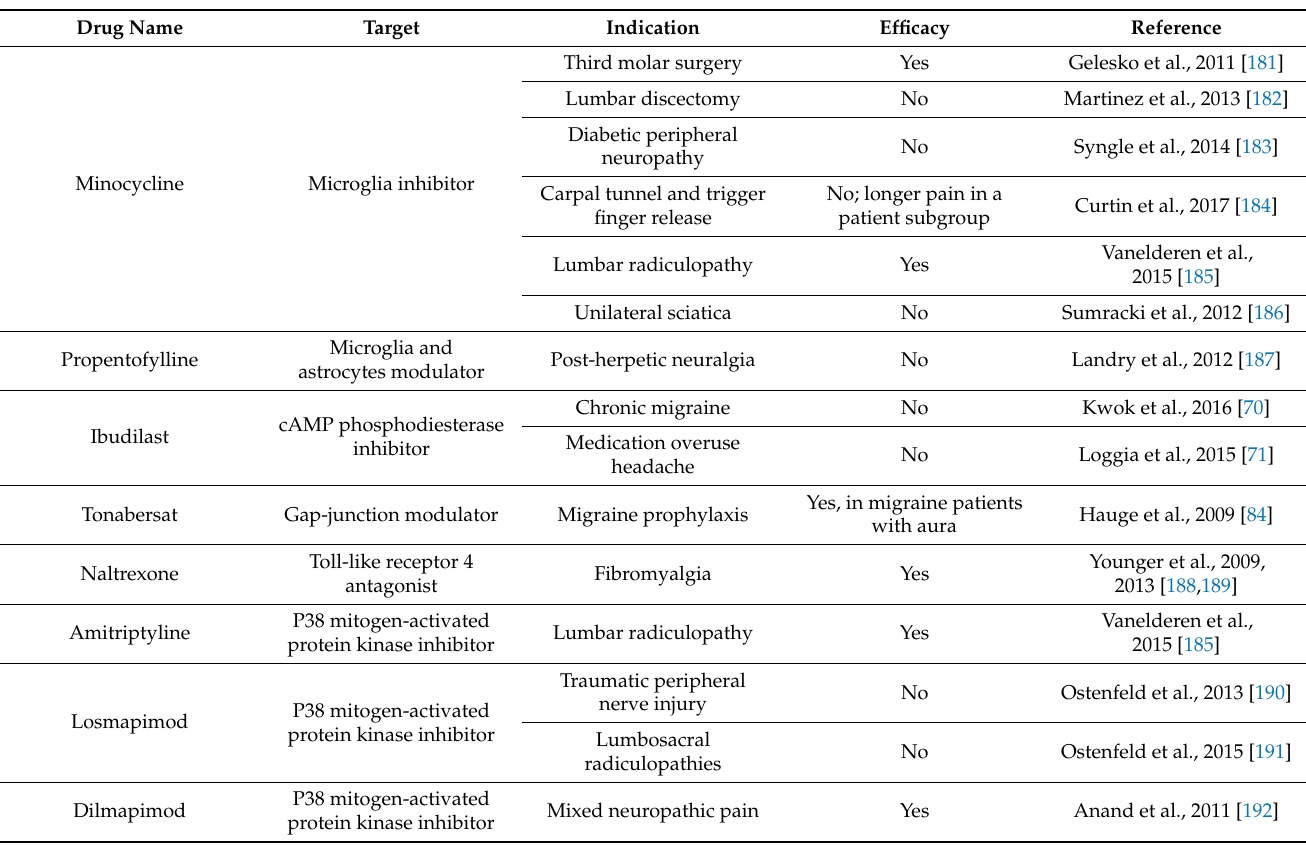
Table 2. Clinical trials using glial